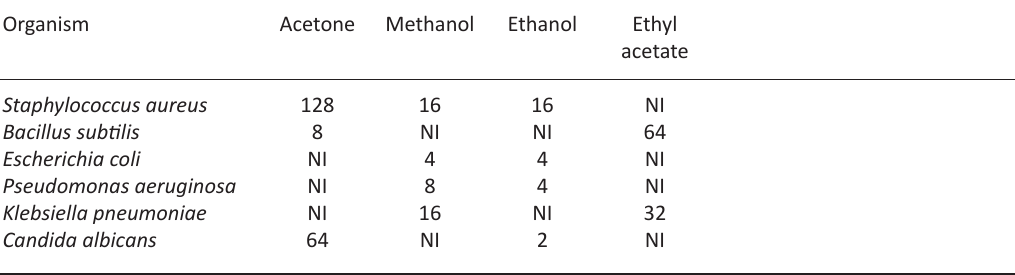
Table 4. Minimum inhibitory concentration of passion fruit peel extracts (mg/ml -1 ) Organism